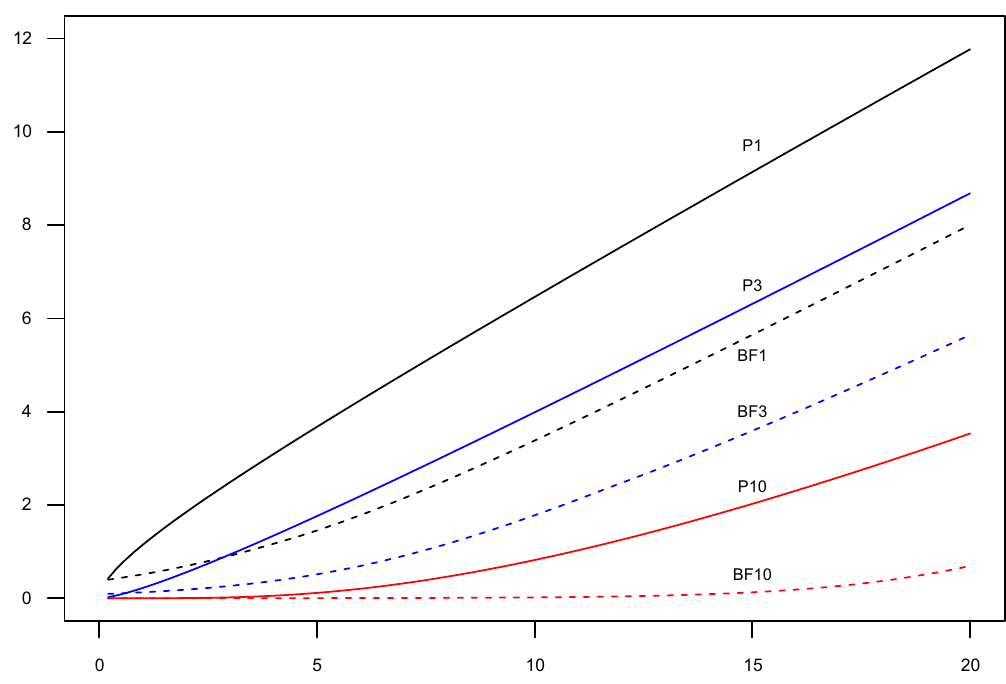
log ( p ) (Pd) and log ( Pr ( H 0 D )) (BFd), respectively, as a − − |